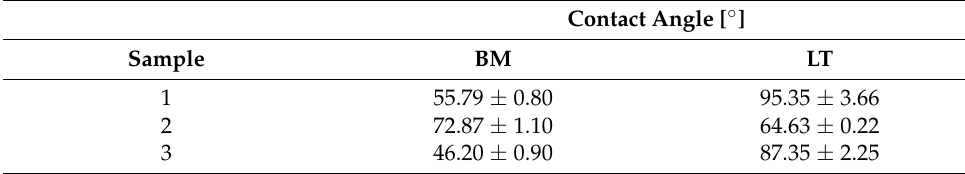
Table 8. The contact angle